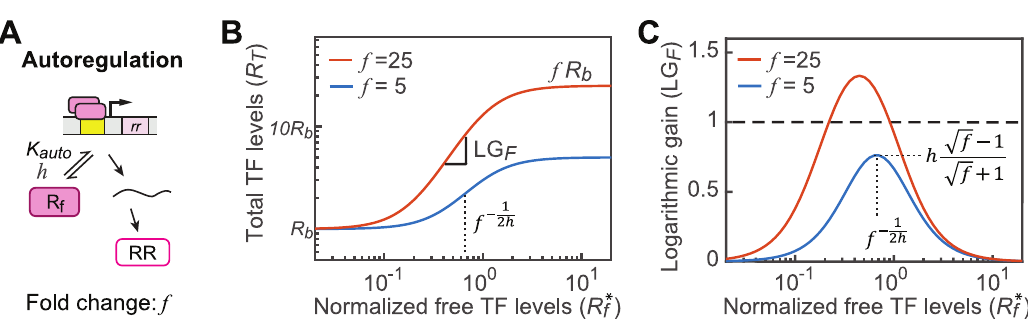
Fig 2. Low values of the transcriptional fold change of the autoregulated promoter are advantageous to avoid bistability. (A) The autoregulation module and the relevant parameters. The fold change ( f ) and the binding cooperativity ( h ) determine expression levels of the autoregulated TF (B) and the logarithmic gain LG (C). A high f value (orange) results in the maximal F logarithmic gain exceeding 1 (dashed line) and the system potentially can be